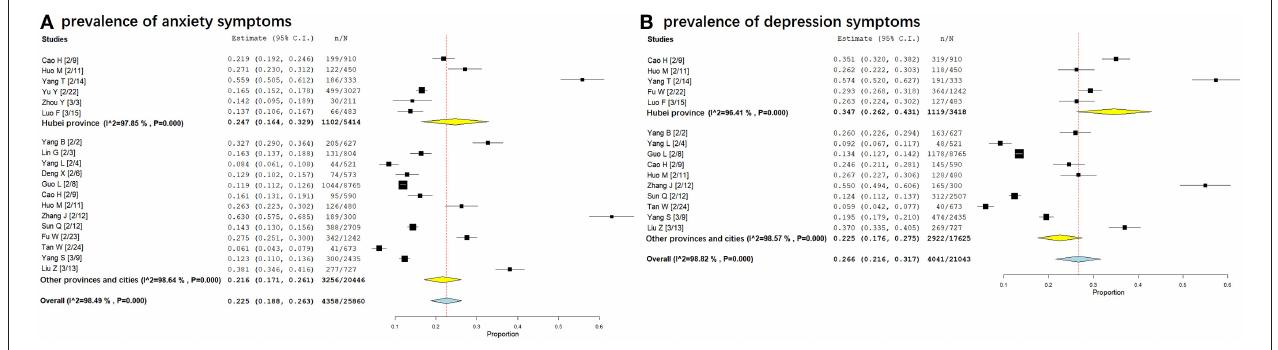
FIGURE 3 | Forest plots: the prevalence of anxiety and depression symptoms in Hubei province and other provinces/cities. [ (A) prevalence of anxiety symptoms in Hubei province and other provinces/cities; (B) prevalence of anxiety symptoms in other provinces/cities outside Hubei province and other provinces/cities].